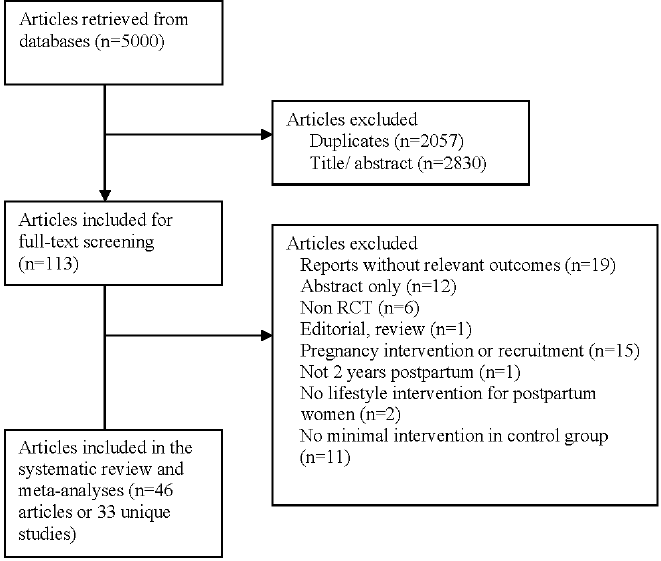
Figure 1. Flowchart of studies included .